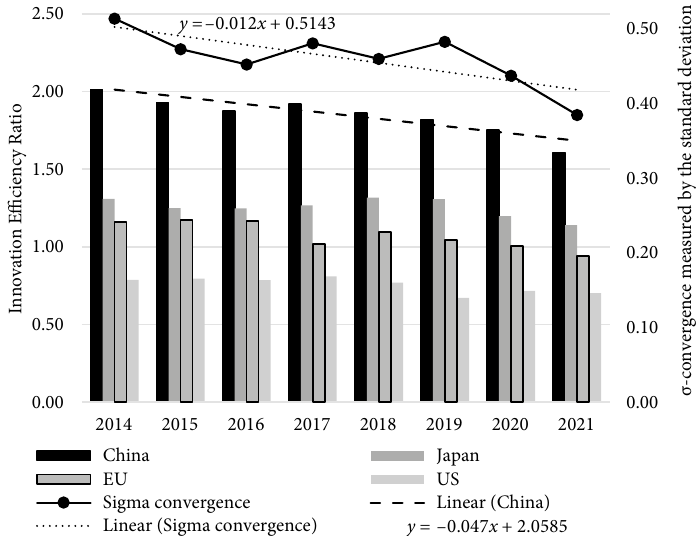
y = –0.047 x + 2.0585 Figure 6. The values of the Innovation Efficiency Ratio for China and the Triad: the EU, Japan, and the US (source: author’s computations using data from the European Innovation Scoreboard 2021)